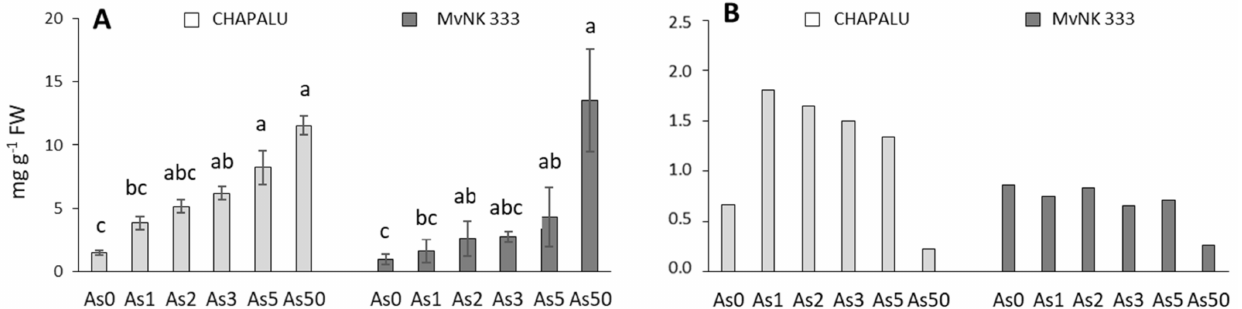
Figure 6. Arsenic (As) content in shoots ( A ) of two cultivar of maize (cvs. Chapalu and MvNK 333) and bioaccumulation factor ( B ). The differences between variants of the experiment were deter- mined using the Kruskal–Wallis test followed by the Dunn’s post hoc test for multiple comparisons ( p < 0.05) ( A ). Different letters on the top of bars indicate a significant difference ( p < 0.05) between variants of the experiment for each cultivar. Data are presented as means ± SD from three biological replicates (n = 6). As0, As1, As2, As3, As5 and As50—arsenic addition to soil in mg kg − 1